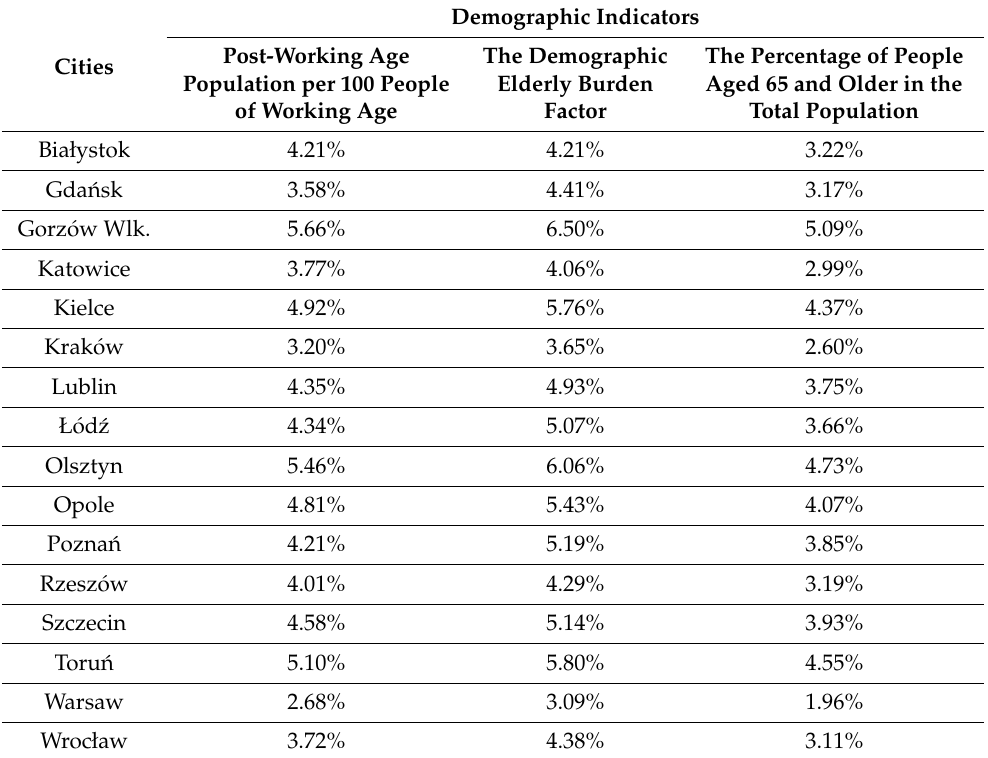
Table 2. Average annual rate of change in senior demographic indicators between 2010 and 2020 in surveyed Polish